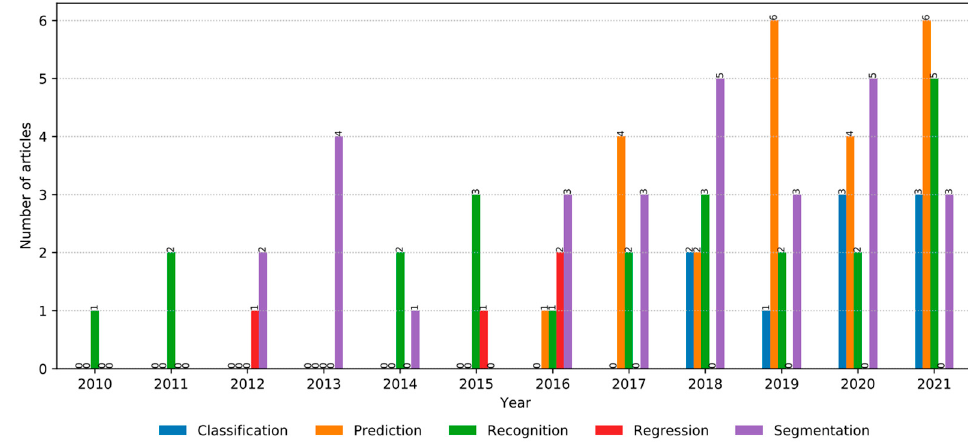
Figure 4. Distribution of AI/ML Problem types.